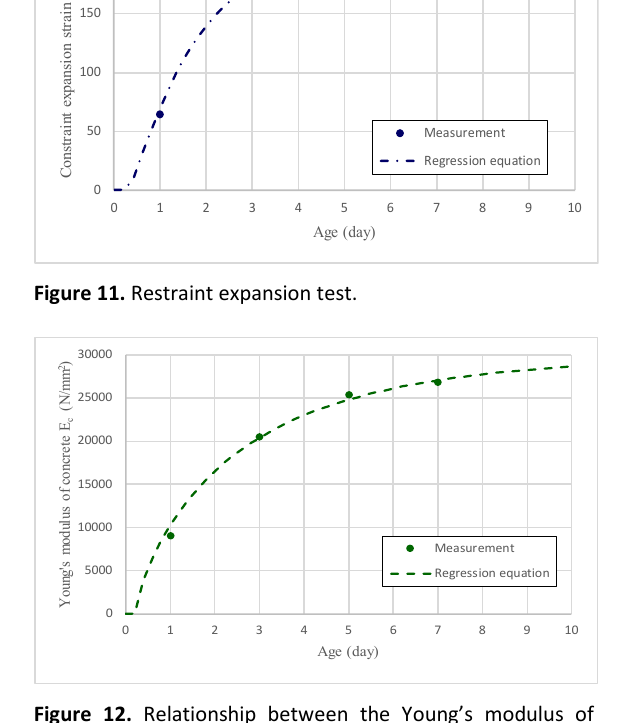
Figure 12. Relationship between the Young’s modulus of concrete and age.